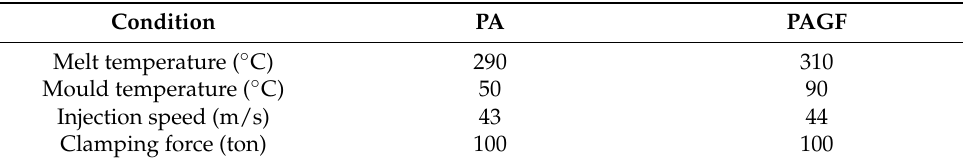
Table 6. Injection conditions.